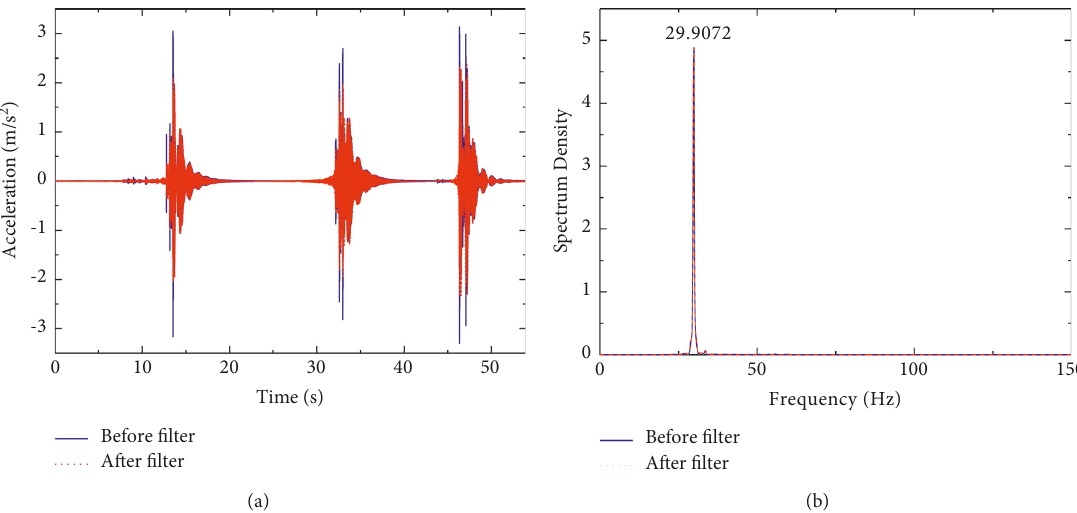
Figure 9: Measured acceleration time-history curves and frequency spectrums of steel beam before assembly. (a) Acceleration time-history curves. (b) Acceleration frequency spectrums.